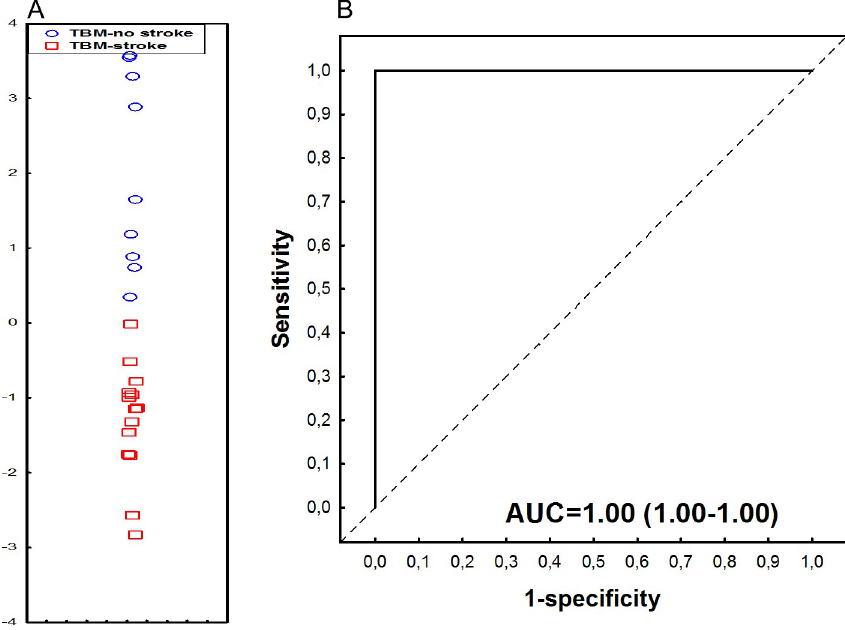
Fig 7. Accuracy of the 3-marker serum host protein biosignature (IL-1 β , IL-4, and Alpha-2-antitrypsin) in indicating stroke in children with TBM. (A) Scatterplot depicting the separation of children as TBM with stroke or no stroke using the 3-marker biosignature. (B) ROC curve depicting the performance of the 3-marker biosignature. Red squares: TBM-related stroke. Blue circles: TBM, no stroke.